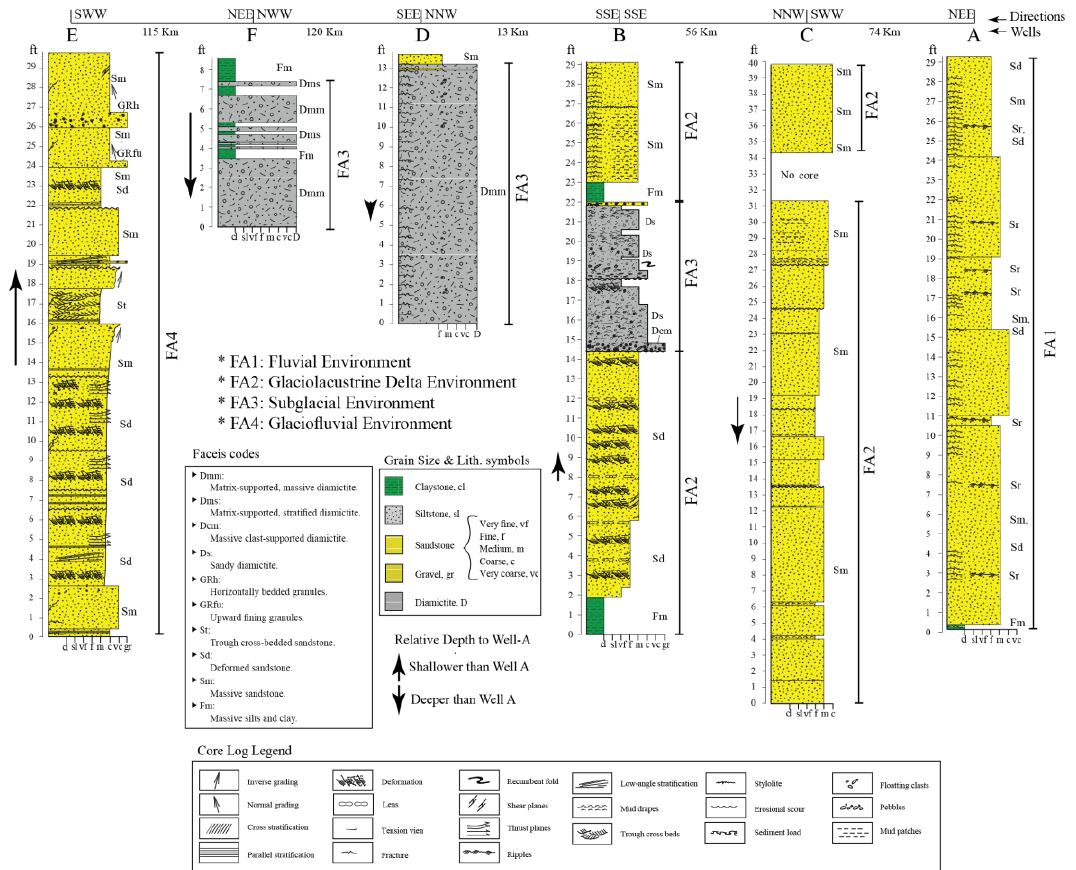
Figure 2. Core stratigraphic columns showing the different facies associations for all wells: FA1: fluvial, FA2: glaciolacustrine delta, FA3: subglacial, and FA4: glaciofluvial outwash facies.